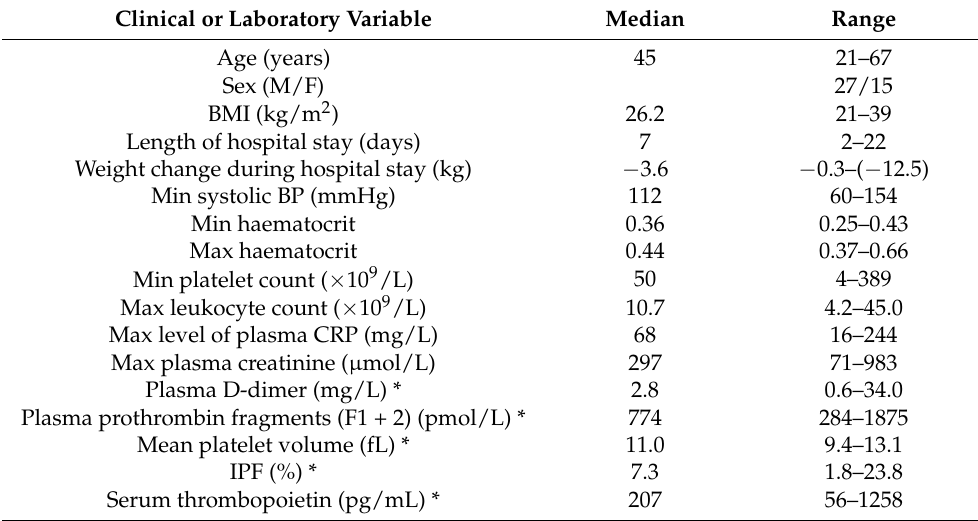
Table 1. Clinical characteristics and laboratory findings of 42 patients with acute Puumala han- tavirus